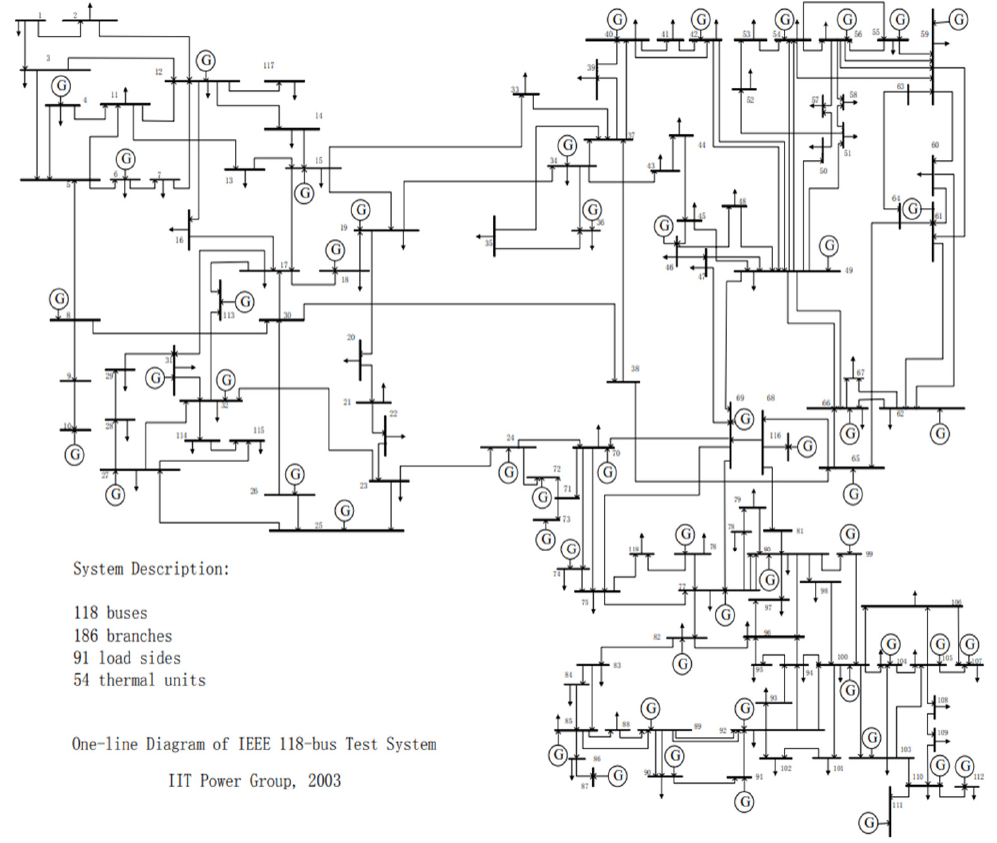
Figure 12. Standard IEEE118-node system.